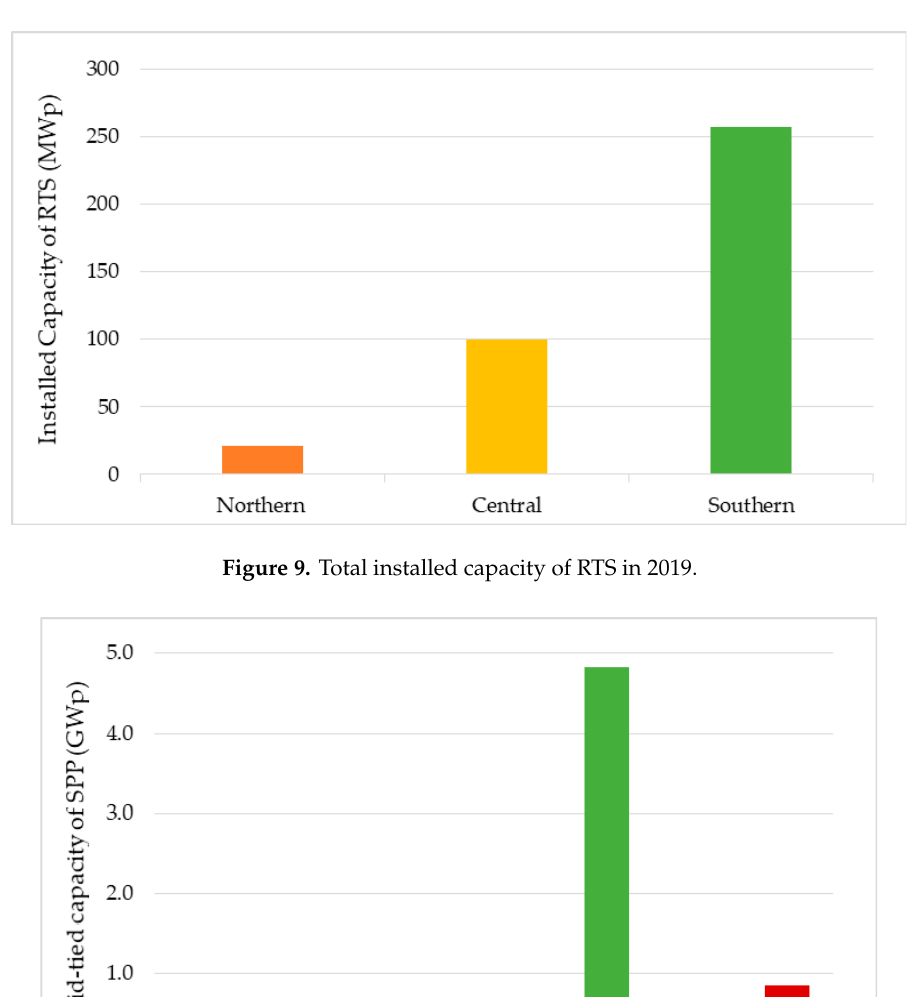
Figure 9. Total installed capacity of RTS in 2019.